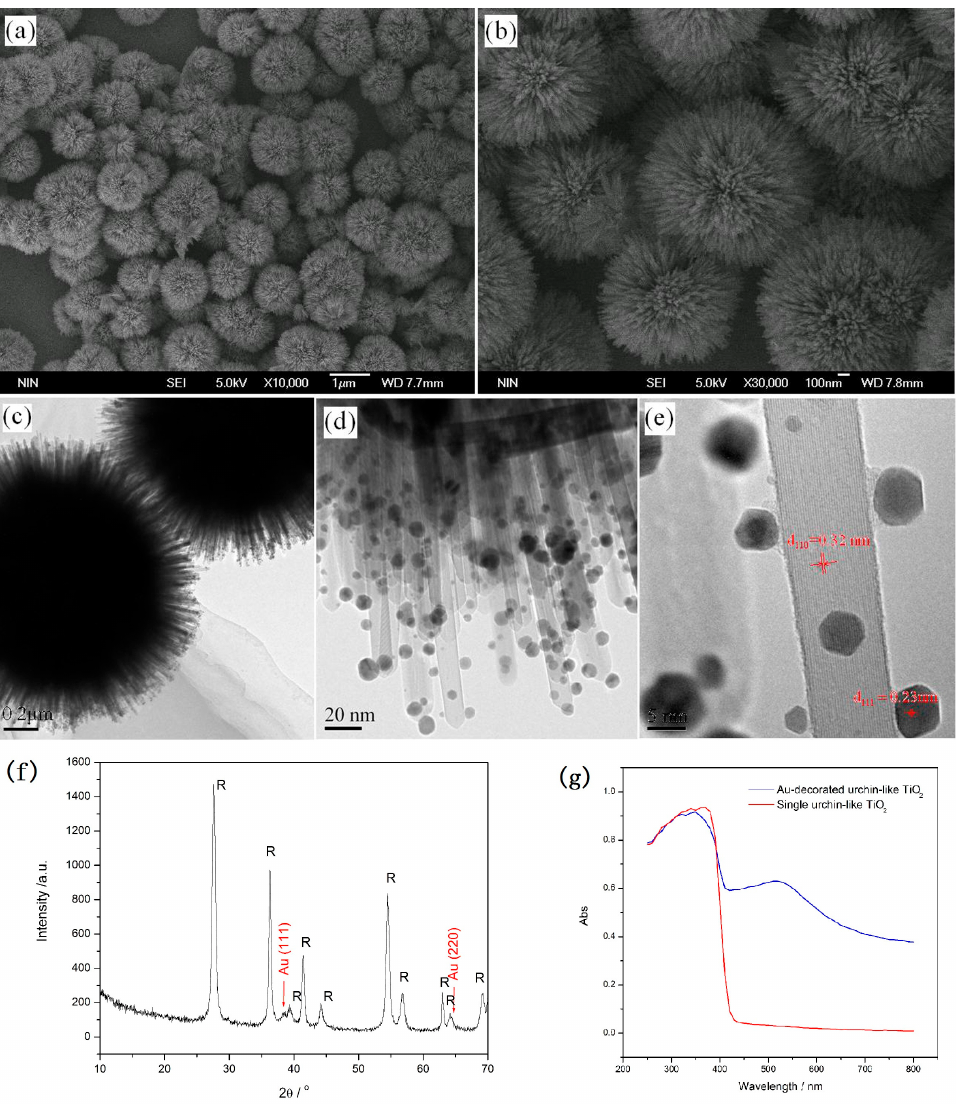
Figure 12. SEM images ( a , b ), TEM images ( c – e ), XRD pattern ( f ) and UV-Vis absorption spectra ( g ) of Au-decorated 3D urchin-like TiO 2 nanostructures [31].